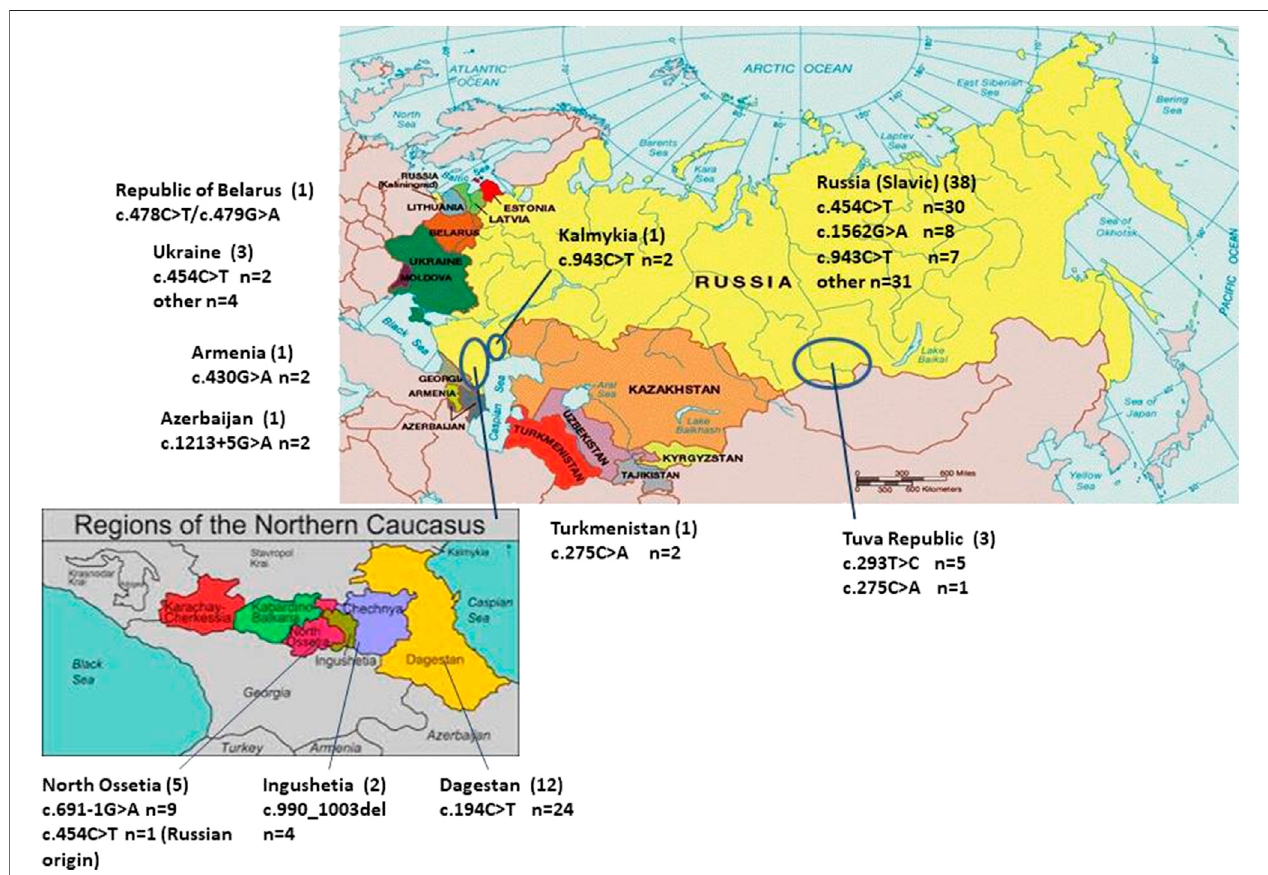
FIGURE1 | Distribution ofthe pathogenic ARSB alleles among patientsfrom different population groups ofRussia and other republics ofthe Former Soviet Union. The number of patients is indicated in brackets. n — number of pathogenic ARSB